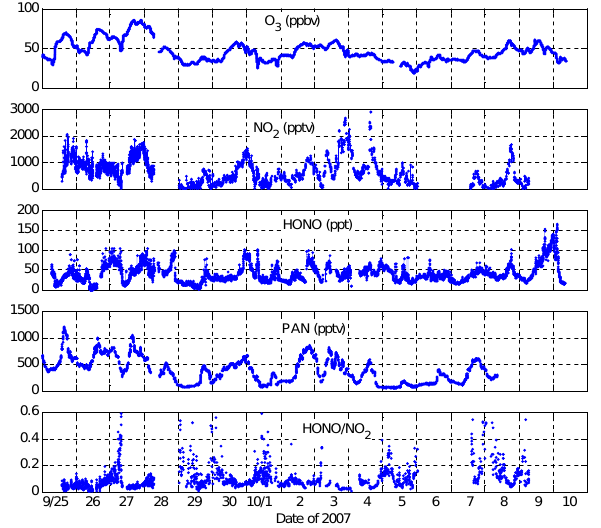
Fig. 4. Time series of measured ozone, NO 2 , PAN, HONO, and HONO/NO 2 ratio between 25 September and 10 October during BEARPEX2007. HONO measurements made by wet chemistry are shown. PAN was measured using CIMS (Wolfe et al., 2009).